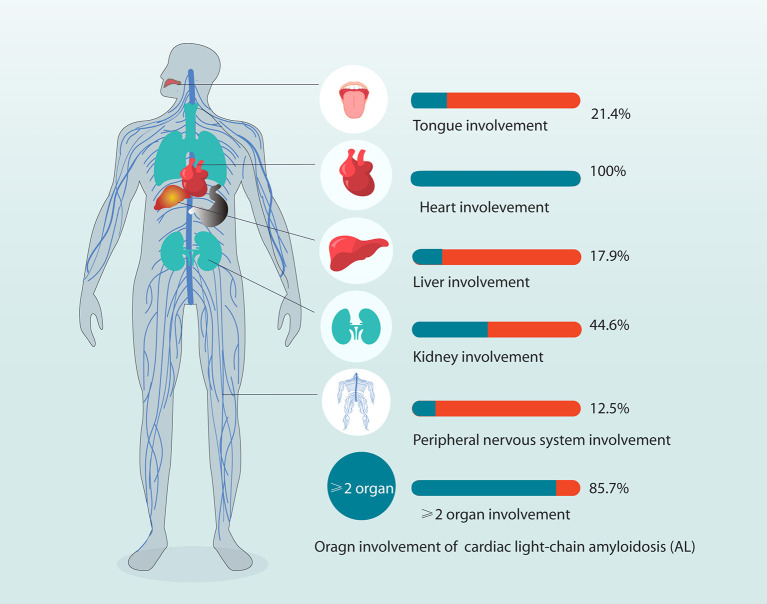
Organ involvement in patients with systemic light-chain amyloidosis in the study. Organ involvement included the heart (100%), kidney (44.6%), liver (17.9%), tongue (21.4%), and PNS (12.5%) (more details in Supplementary Figure 2). In total, 85.7% of patients have at least two organs involved. PNS, peripheral nervous system.